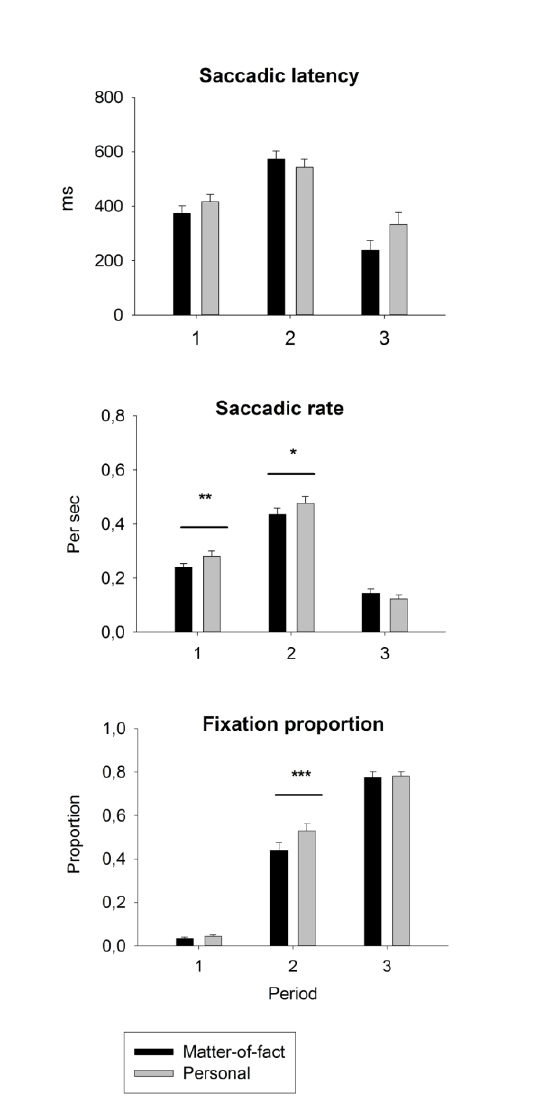
Figure 3. Condition-wise means and standard errors of eye- movement measures of social attention during each time period. Saccadic latency indicates how fast, after the beginning of a time period, the participants shift their attention to the other discussant. Saccadic rate describes how often the participants shift their attention between the discussants. The fixation proportion on the second speaker indicates how large is the portion of fixations directed to the second speaker in each time period. ***p < 0.001, **p < 0.01, *p <